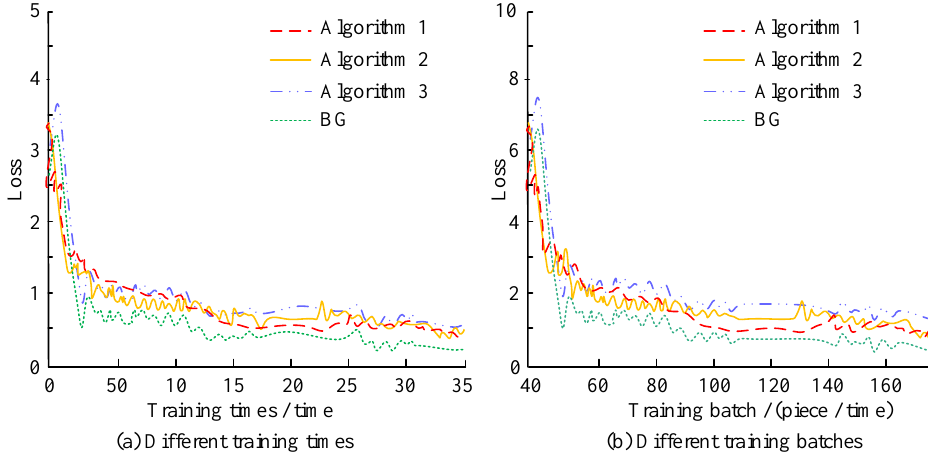
Figure 6. Loss value under different training times and different batches. (( a ): When the training times are 20, the error convergence values of BG algorithm, belief propagation algorithm, shortest path algorithm and improved cooperative optimization algorithm are 0.456, 0.625, 0.689 and 0.721 respectively. ( b ): When the training batch size is 100 times, the error convergence values of the four algorithms are 0.898, 1.035, 1.234 and 1.563 respectively.).